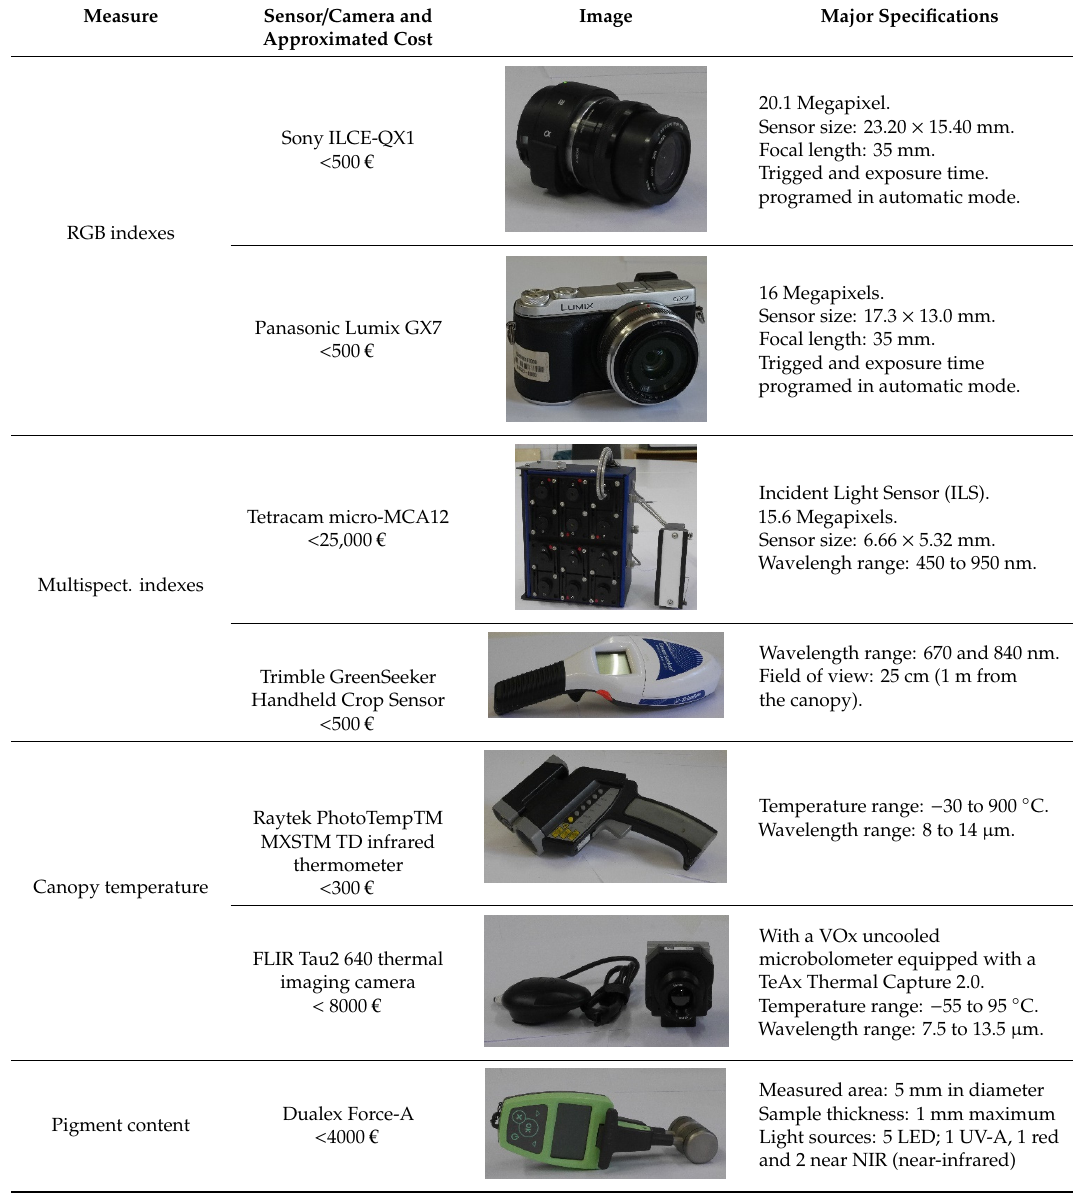
Table 3. Sensors and cameras used during this experiment and their major specifications.